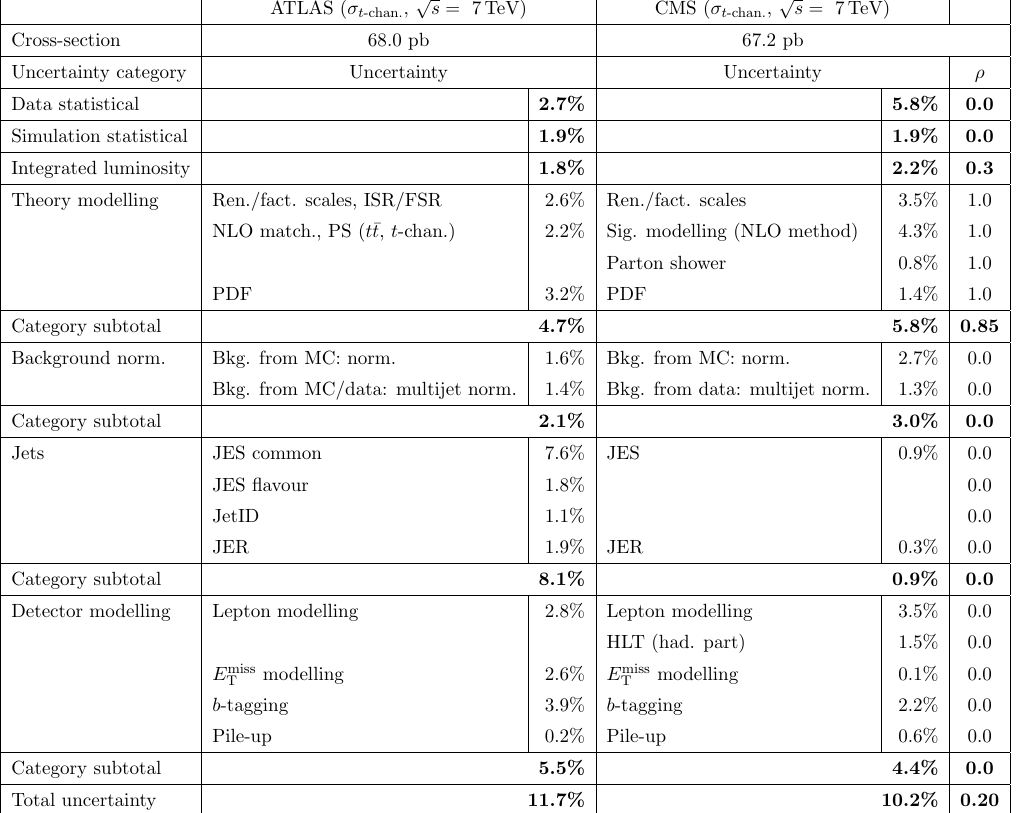
Table 9 . Measured cross-sections, uncertainty components, their magnitudes (relative to the indi- vidual measurements) and the correlation ( (cid:26) ) between the ATLAS and CMS (cid:27) t -chan. measurements at p s = 7 TeV. Uncertainties in the same row can be compared between experiments, as detailed in the text. The naming conventions follow those of the corresponding